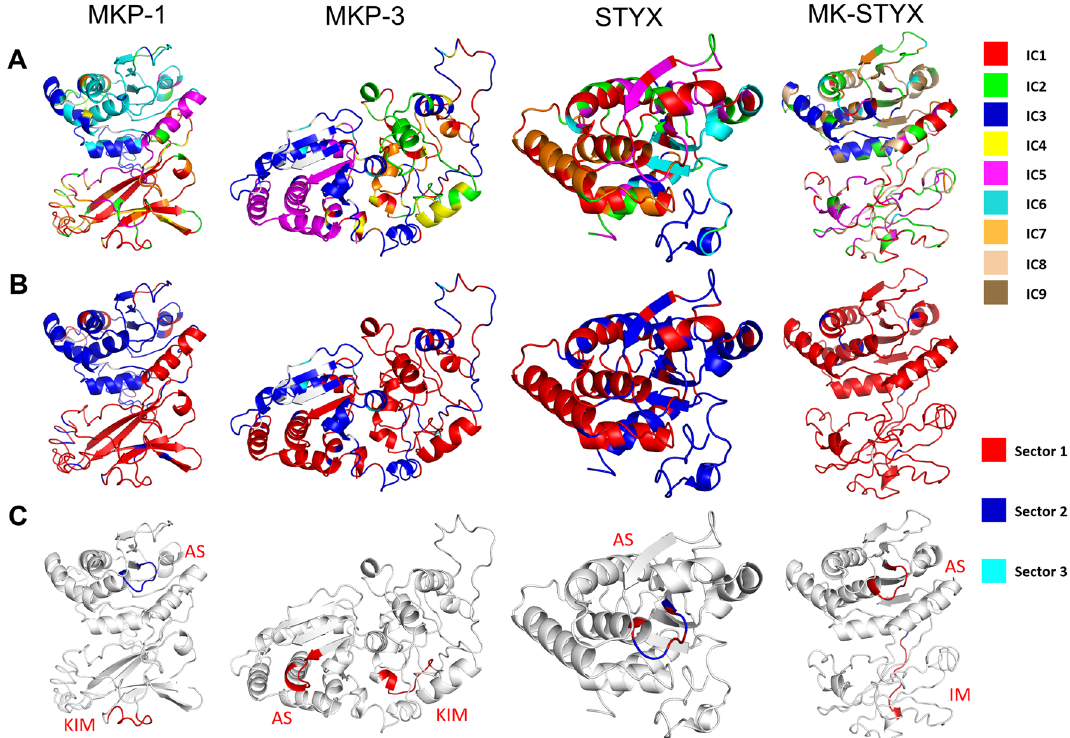
Figure 6. Protein Structure with ICs and sectors from statistical coupling analysis. In each column there are 3 rows, ( A ) shows the protein structure with coloring based on ICs, ( B ) shows the same sequence with sector coloring, and ( C ) has the same structure highlighting only the two motifs, AS (active site), and KIM (kinase interacting motif), each colored with the corresponding sector from above. The columns are for one of each of the proteins studied here (MKP-1, MKP-3, STYX, or MK-STYX. The structural integrity is conserved within the active motif of the active PTPs and pseudophosphatases. However, the KIM domain of MK-STYX has an altered shape. Predictive model of the macromolecular structure of proteins were generated by Iterative Threading ASSEmbly Refinement (I-TASSER) (https:// zhang group. org/I- TASSER/) 54 . Structures were colored by